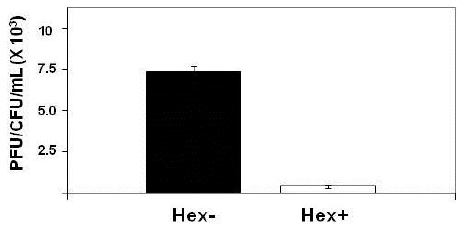
Figure 4. Effect of hex mutation on stability of MG1655::λ imm434 lysogens. MG1655(λ imm434 ) and MG1655(λ imm434hex− ) were grown to saturation, washed